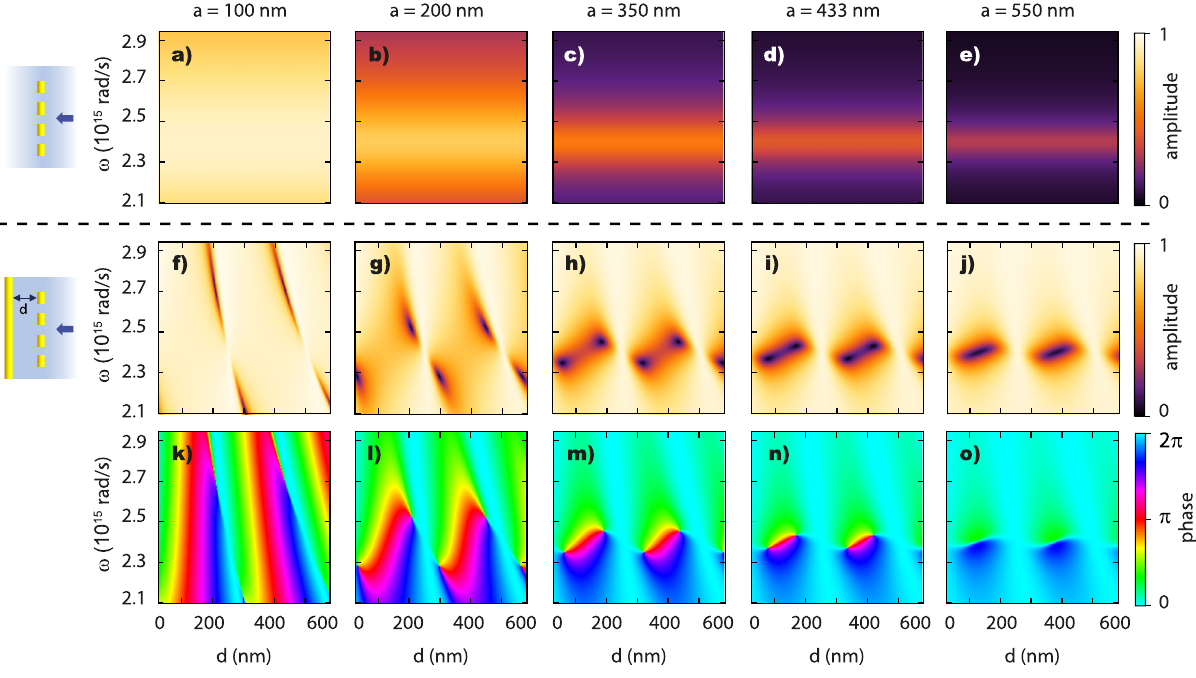
Figure2: CalculatedresponseofSalisburyscreensinreflection.Fromlefttorightthecolumnsdisplaymetasurfacesconsistingofscatterersin a square geometry with a pitch increasing from 100 to 550 nm and with fixed antenna parameters V = 6.9 ⋅ 10 − 23 m 3 , ω 0 (cid:1) 2 . 4 ⋅ 10 15 rad / s and γ (cid:1) 9 . 3 ⋅ 10 13 Hz. Toprow (a – e):amplituderesponseof theparticlearraysas a functionof frequencyinabsenceof thebacking mirror,showing a Lorentzianresponsearound the resonance frequency ω 0 . Center(f – j) andbottom (k – o) rows show thefull etalonresponseinamplitudeand phase respectively, as a function of frequency and metasurface – mirror spacing d , employing a 50 nm Au back re fl ector. Re fl ection phase is referenced to that in absence of the